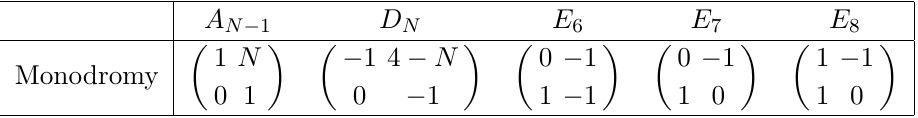
If we T-dualize along one of the directions of the (cid:12)ber, we map Type IIB to Type IIA and exchange (cid:28) $ (cid:26) , which means that we have an elliptic (cid:12)bration with a monodromy acting on (cid:26) , not on (cid:28) . This is an example of a non-geometric space, sometimes referred to as a